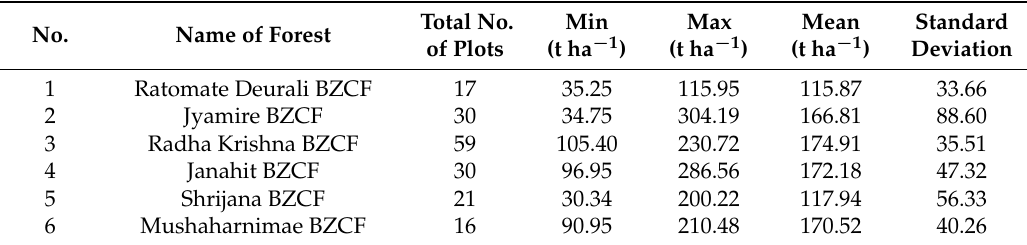
Table 2. Descriptive statistics of plot-level